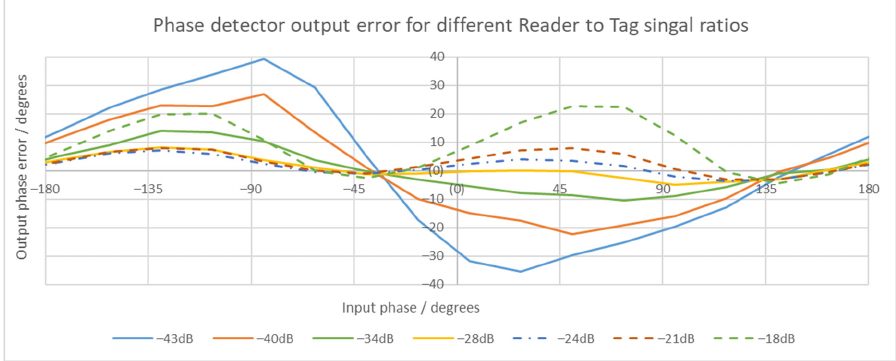
Figure 13. Phase detector output phase error over a full range of input phase. The lines represent different reader-to-tag signal ratios. Except for the − 43 dB signal ratio, all phase errors have an absolute value lower than 30 degrees. The output of the phase detector is valid over complete input phase